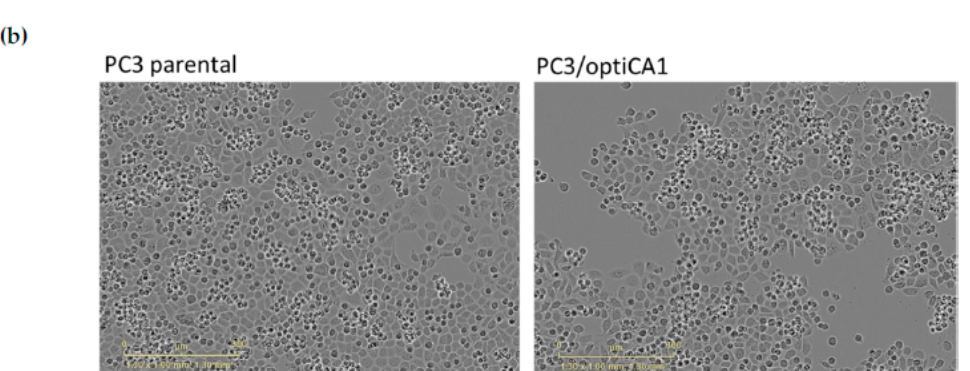
Figure 2. Expression of selected genes responsible for adhesion, cytoskeleton and selected proto-oncogenes and cellular morphology are not changed in PC3 prostatic tumor cells engineered to stable overexpress codon optimized CA1 gene (optiCA1; PC3/optiCA1). ( a ) Reverse transcriptase quantitative PCR; COL1A1–alpha-1 type I collagen, COL4A4–alpha-4 type IV collagen, LAMC2–laminin subunit gamma-2, CTHRC1 – collagen triple helix repeat containing protein 1, WNT7B–Wingless-Type MMTV Integration Site Family, Member 7B; the data are expressed as means of quadruplicates ± SD. ( b ) morphology of parental PC3 and PC3/optiCA1 cells; light-microscope images from IncuCyte ZOOM Kinetic Imaging System, scale bar: 300 μ m.